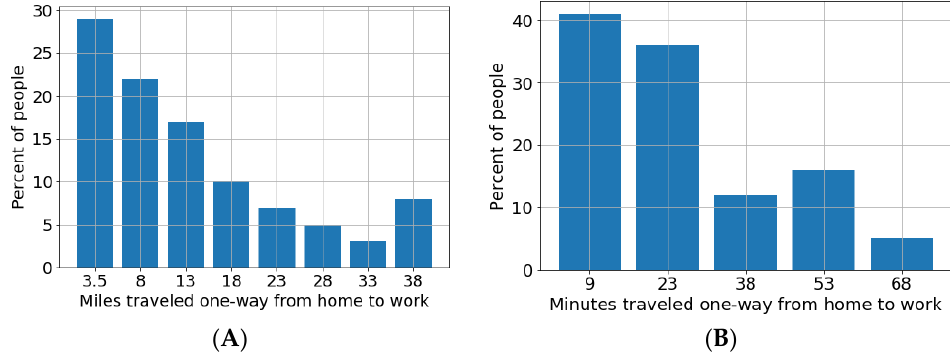
Figure 4. Commute distance ( A ) and time ( B ) for each driver from home to the workplace.